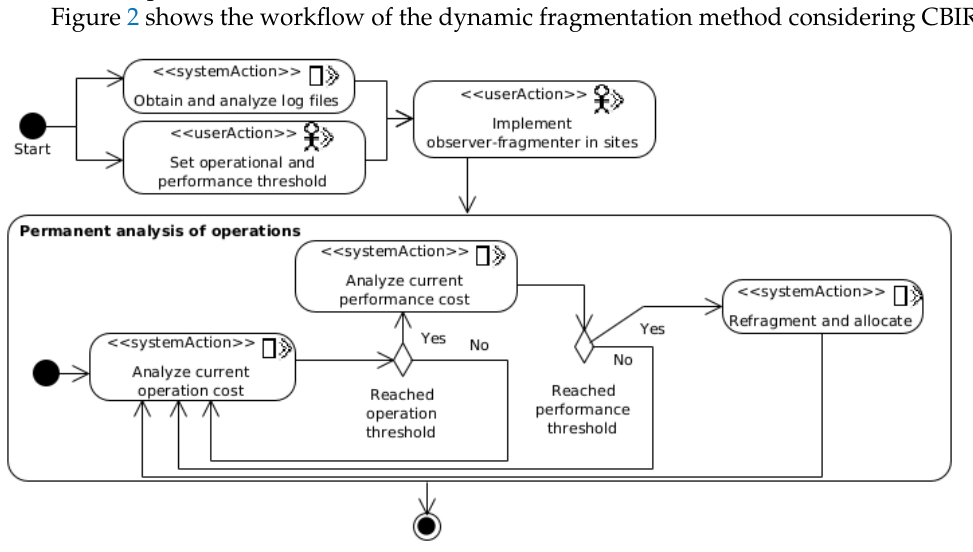
6 of 20 Figure 1. Static fragmentation method workflow contemplating CBIR.